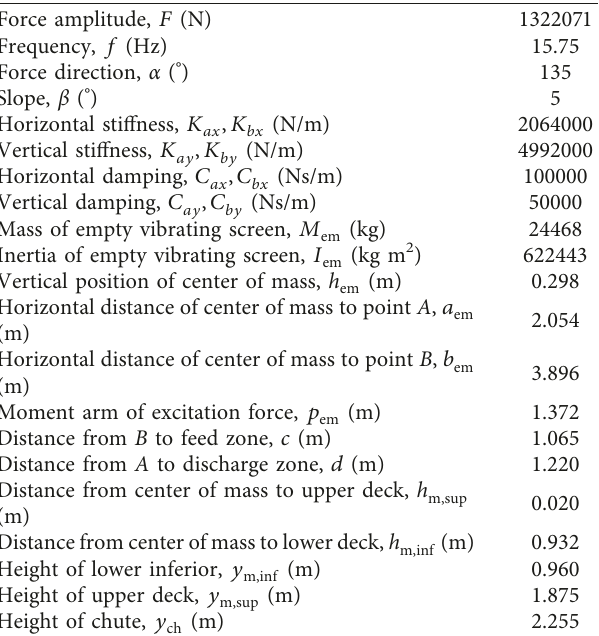
Table 3: Parameters of empty vibrating screen used for the dy- namical simulations.